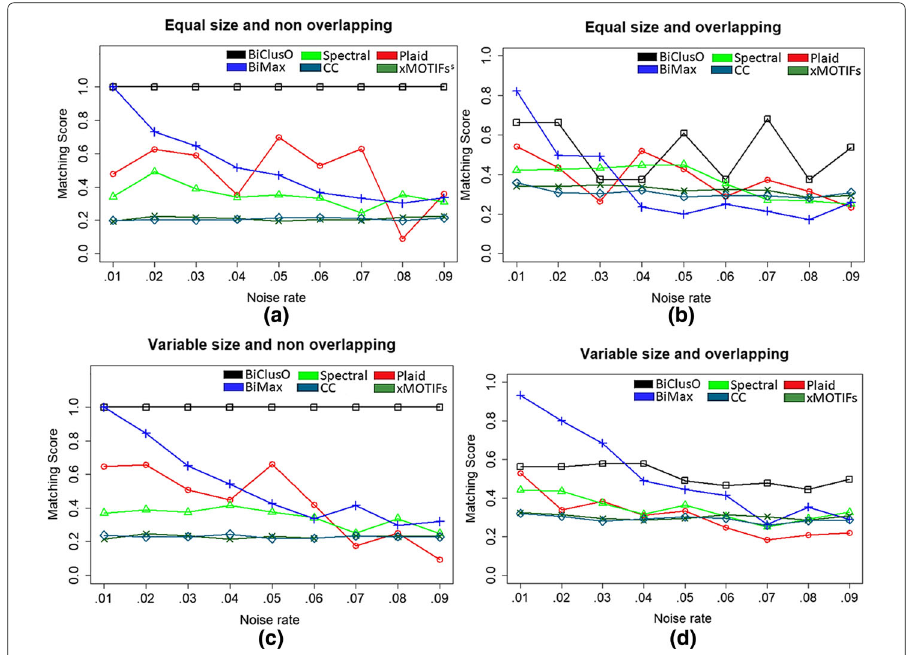
Fig. 7 Performance of different algorithms in terms of average module recovery on synthetic data